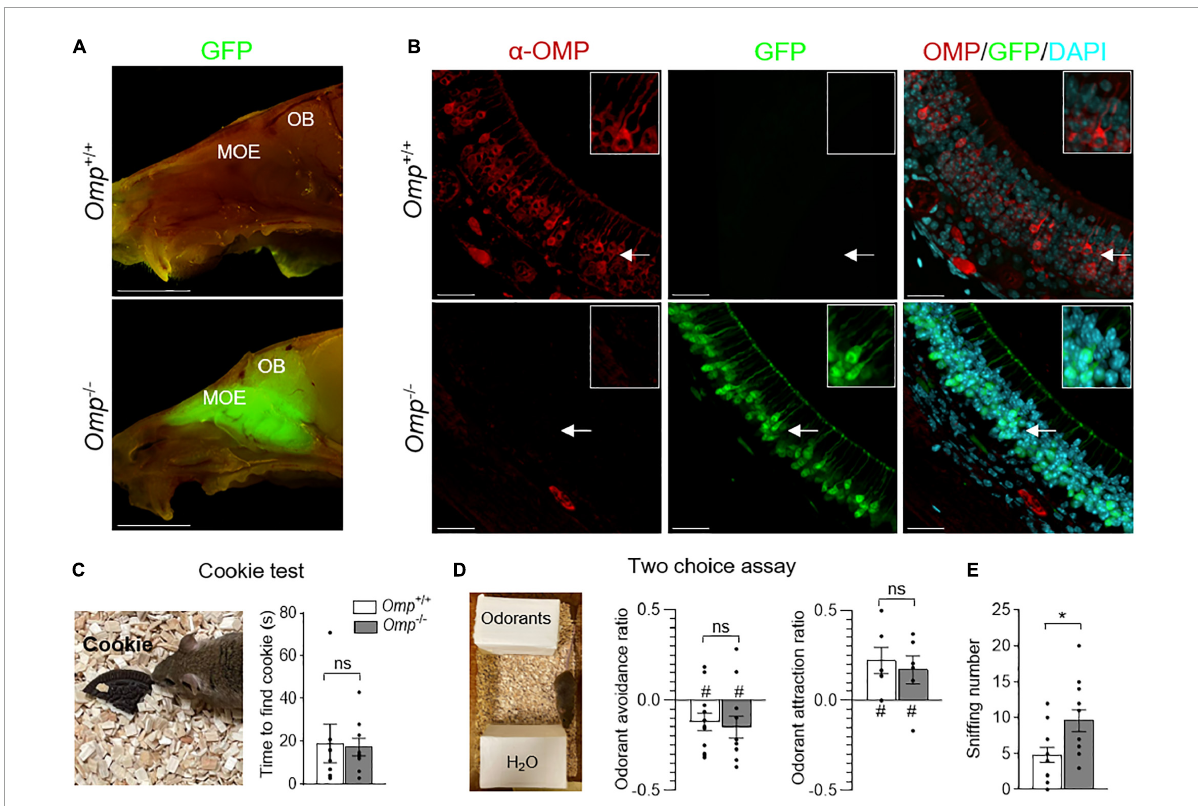
FIGURE1 Olfactory responses observed in OMP null mice. (A) Sagittal cuts trough the heads of Omp + / + and Omp − / − mice, where GFP replaces OMP as the histological reporter of mature olfactory sensory neurons. The main olfactory epithelium (MOE) contains olfactory sensory neurons that project to the olfactory bulb (OB) of the brain. Scale bars: 1 cm. (B) α -OMP immunostaining of the MOE of Omp + / + and Omp − / − mice showing the absence of OMP expression in Omp − / − mice. In red, the OMP expression in Omp + / + mice. In green, the GFP expression in Omp − / − mice. In blue, the nuclei stained with DAPI. Insets show OSNs details indicated by white arrows on main pictures. Scale bars: 20 µ m. (C,D) The general olfactory function was not affected in Omp − / − mice. (C) In a cookie test, no significant difference is observed between the Omp + / + (in white) and Omp − / − (in gray) mice in the latency to find an odorant Oreo R (cid:13) cookie hidden in the bedding. (D) In two choice assays, tested odorants are placed opposite to the odorless water (H 2 O), both genotypes displayed similar innate odorant avoidance (butyric acid) or attraction (peanut butter solution). (E) Olfactory behavioral compensation observed in Omp null mice. Omp − / − mice show a significant increase of sniffing behavior during the exploration of the innate odorant attraction assay (D) . N = 6–12 animals were used per genotype and condition. Values obtained are represented as mean ± SEM. For odorant avoidance/attraction z values, # p < 0.05. For comparisons between genotypes, two-tailed Student’s t -tests/Wilcoxon w -tests are used, * p < 0.05 and ns for